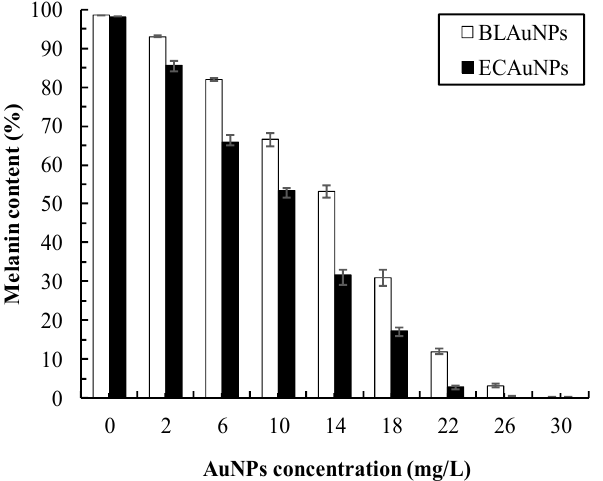
Figure 7. Effects of AuNP concentrations on the melanin content of HEMn cells. Cells were treated with different concentrations of BLAuNPs and ECAuNPs for 24